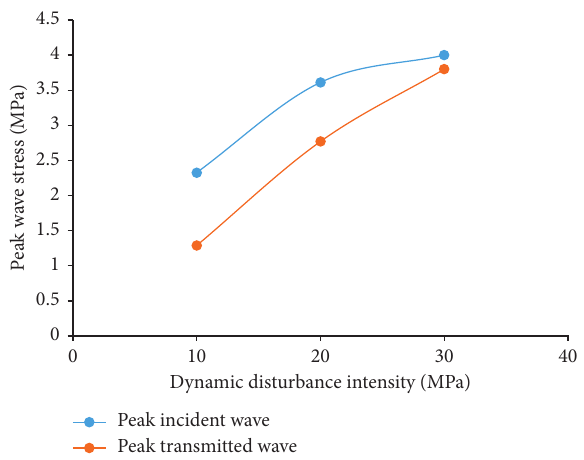
Figure 14: Effect of dynamic disturbance intensity on the peak value of incident and transmitted wave stress.